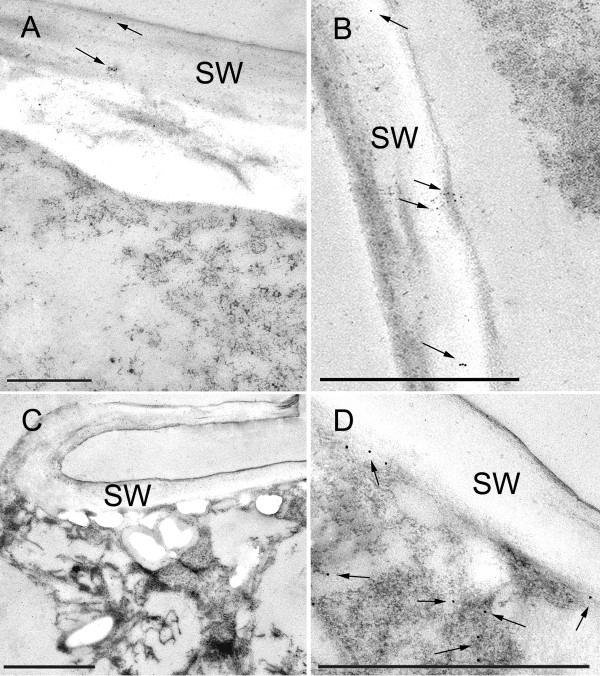
Immunogold labelling with anti-GFP antibody of high pressure-freeze fixed Micrasterias denticulata interphase cells. (A) and (B) Positive signal present in the secondary cell wall (arrows) and absent from the cytoplasm in MdEXP2-GFP-overexpressing cells. Detachment of the wall from the cytoplasm is a preparation artefact. (C) and (D) Label present in the cytoplasm and absent from the cell wall in cells overproducing the free GFP. (D) Inset of (C). SW, Secondary cell wall. Scale bar = 1 μm (A, B, D) and 2 μm (C).